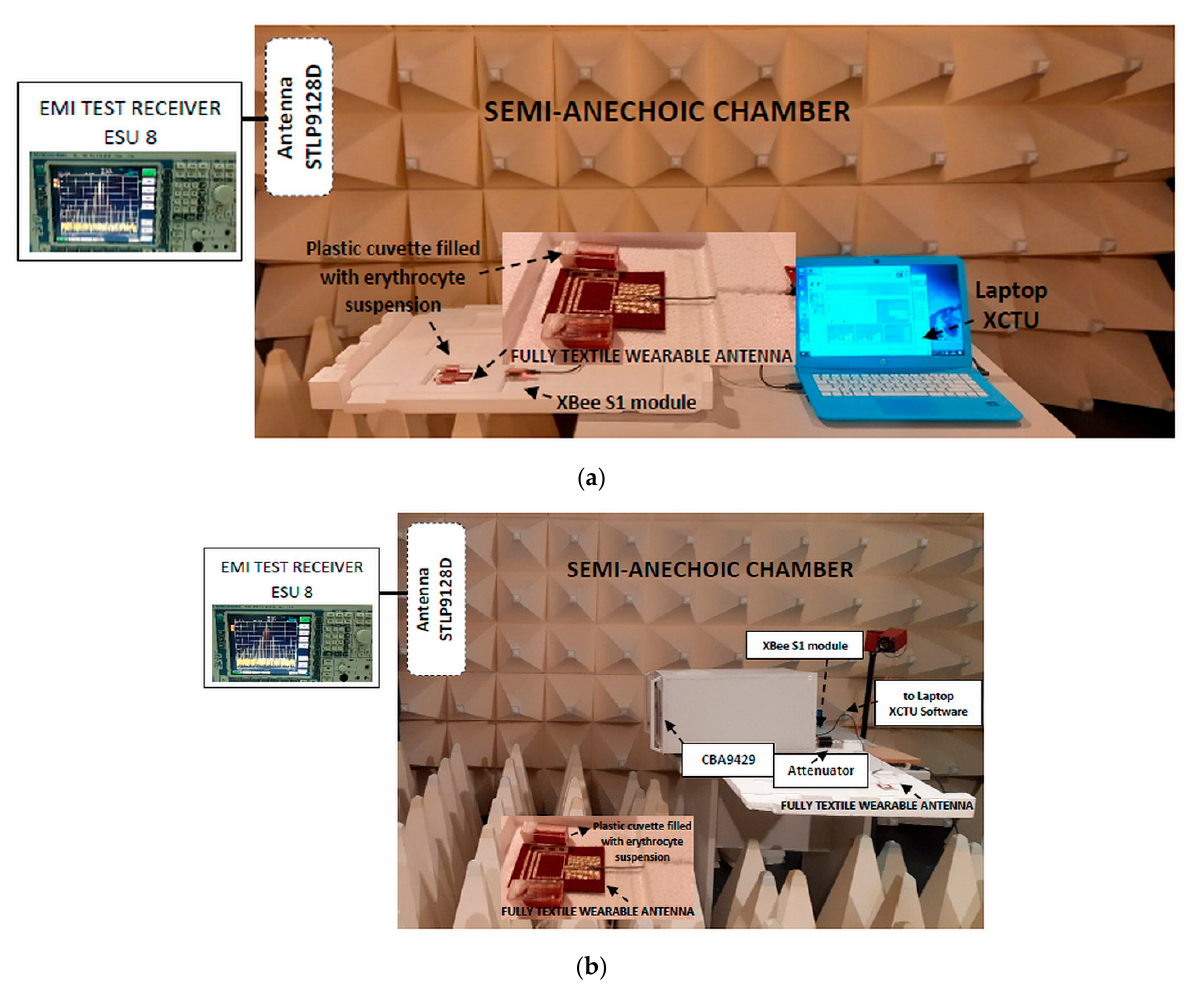
Figure 1. Overview of the exposure setups for investigation of the biological responses at: ( a ) realistic exposure conditions (net input power 6.3 mW) relevant to actual human exposure conditions when the antenna is placed on the human body; ( b ) conservative exposure conditions (net input power 450 mW) at sufficiently high exposure levels. cyte suspensions were placed in these two areas to be investigated under the worst-case scenario (maximum SAR conditions).